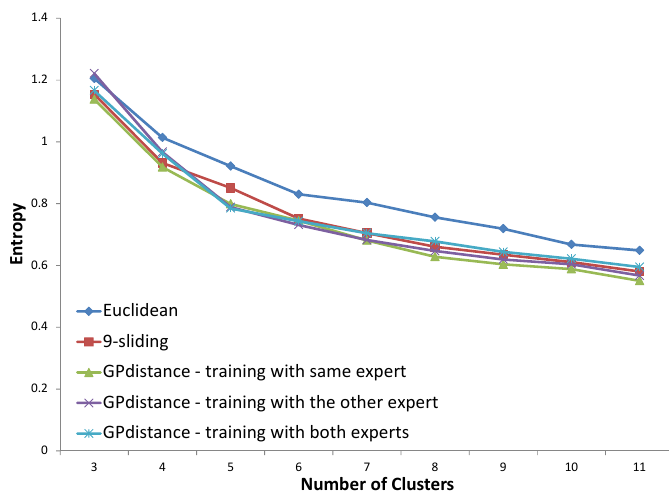
Figure 21. Entropy results for the southern region using the data of expert #1.